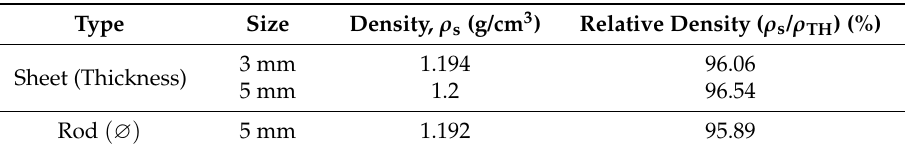
Figure 3. Reivtveld analysis of the MCF/PP composite. Table 1. Relative densities of different die